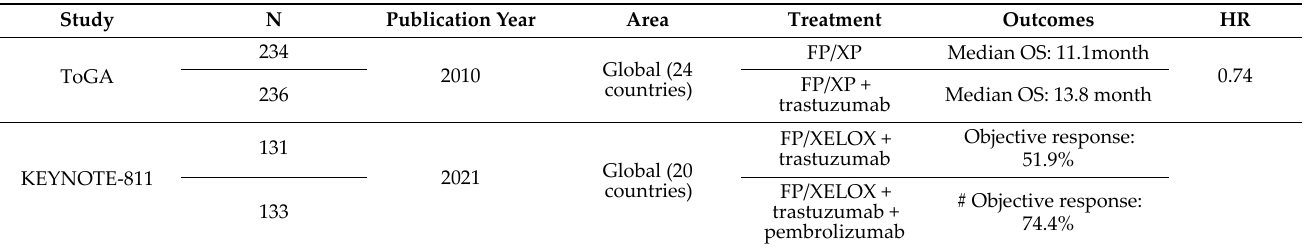
Table 2. Pivotal randomized controlled clinical trial for first‑line human epidermal growth factor receptor 2 (HER2)‑positive gastric